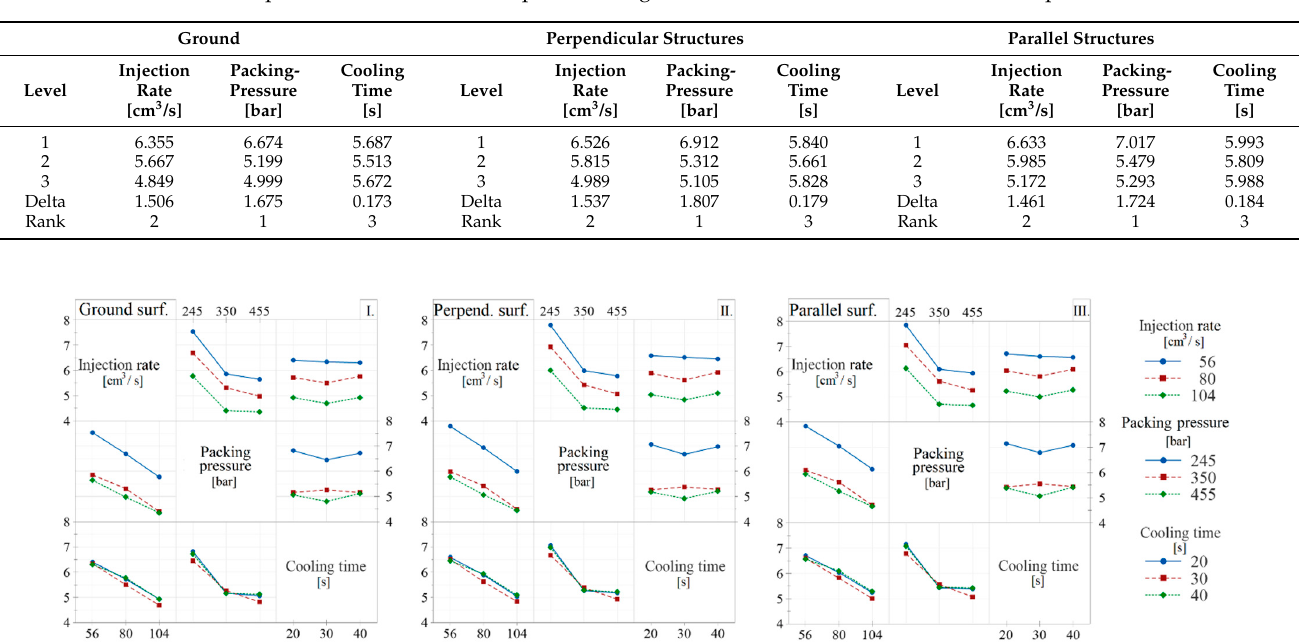
Table 6. Response table of means—three-point bending test, with different surface-structured specimens. Ground Surface